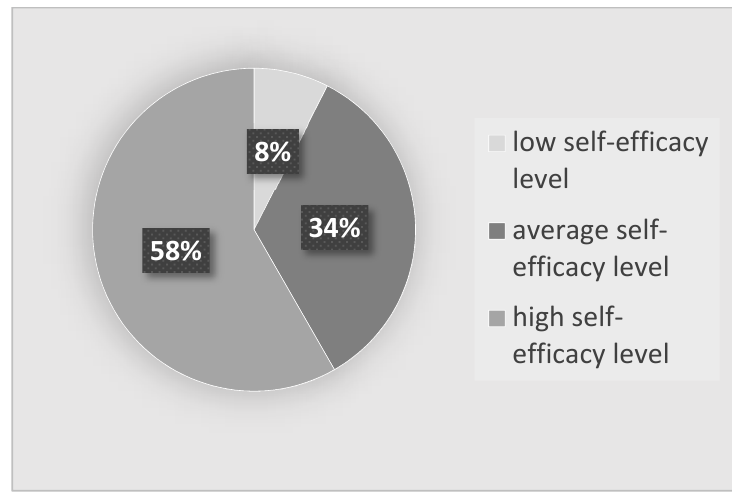
Figure 1. Self-efficacy of the nursing students participating in the study. The majority of the students (N = 233, i.e., 75.9%) were characterized by a high level of self-esteem. The average SES score was 21.19 ± 4.58 points and ranged from 10 points to 32 points. The vast majority (75.9%) of the respondents were characterized by a high level of self-esteem, and 21.2% had an average score (Figure 2)